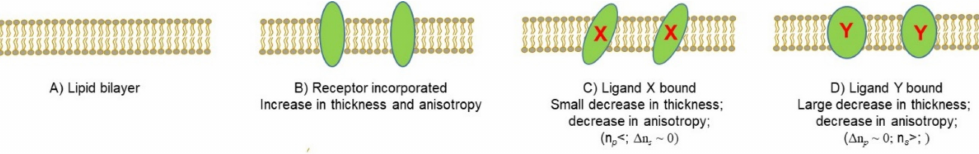
Figure 2. Changes in the optical properties (thickness, refractive indices, and anisotropy) of a lipid bilayer ( A ) following receptor incorporation ( B ) and ligand-induced conformational changes by two different ligands X ( C ) and Y ( D ). Adapted from